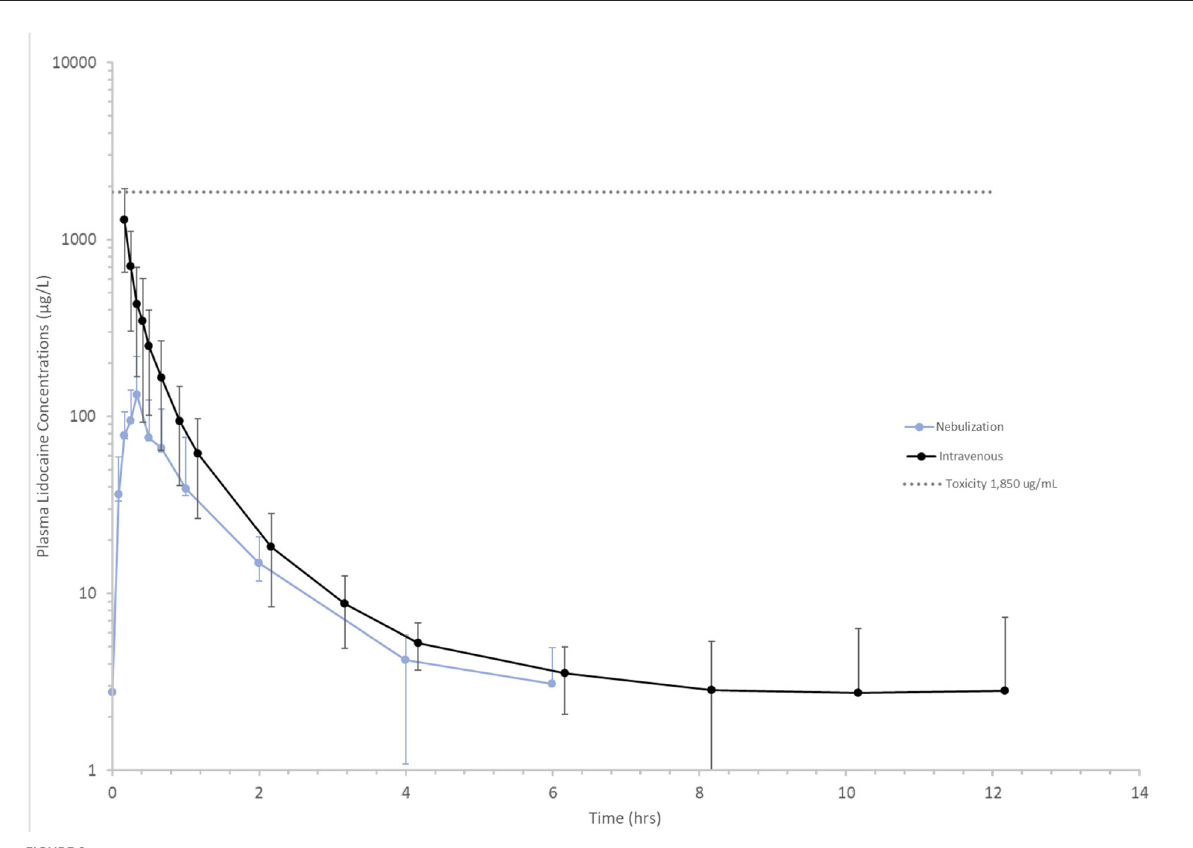
FIGURE2 Mean lidocaine plasma concentrations vs. time following a 1.3 mg/kg intravenous (black line) and 1 mg/kg nebulized (blue line) dose in healthy horses. Toxicity (dotted gray) line represents lower end of the lidocaine concentration range at which clinical signs of intoxication have been observed 1,850 µ g/L